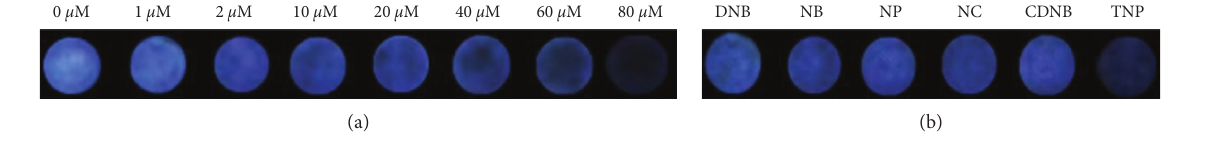
Figure 8: Sensitivity (a) and selectivity (b) of CDFPs to TNP